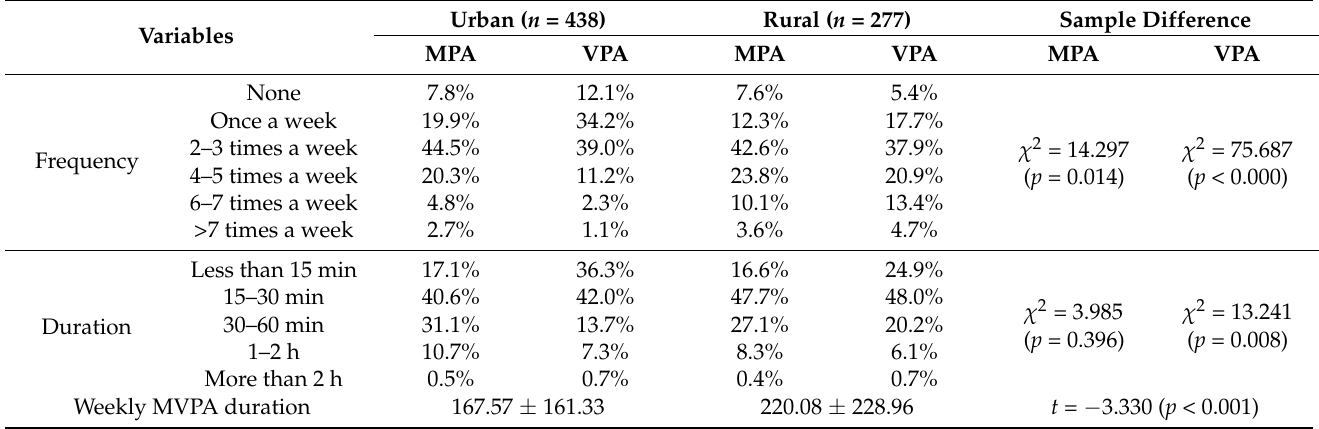
Figure 1. Contrast between urban and rural students in after-school activities. The letters “a” and “b” indicate significant differences ( p < 0.05). Table 3. Comparison of Urban and Rural Student Frequency and Duration of PA.